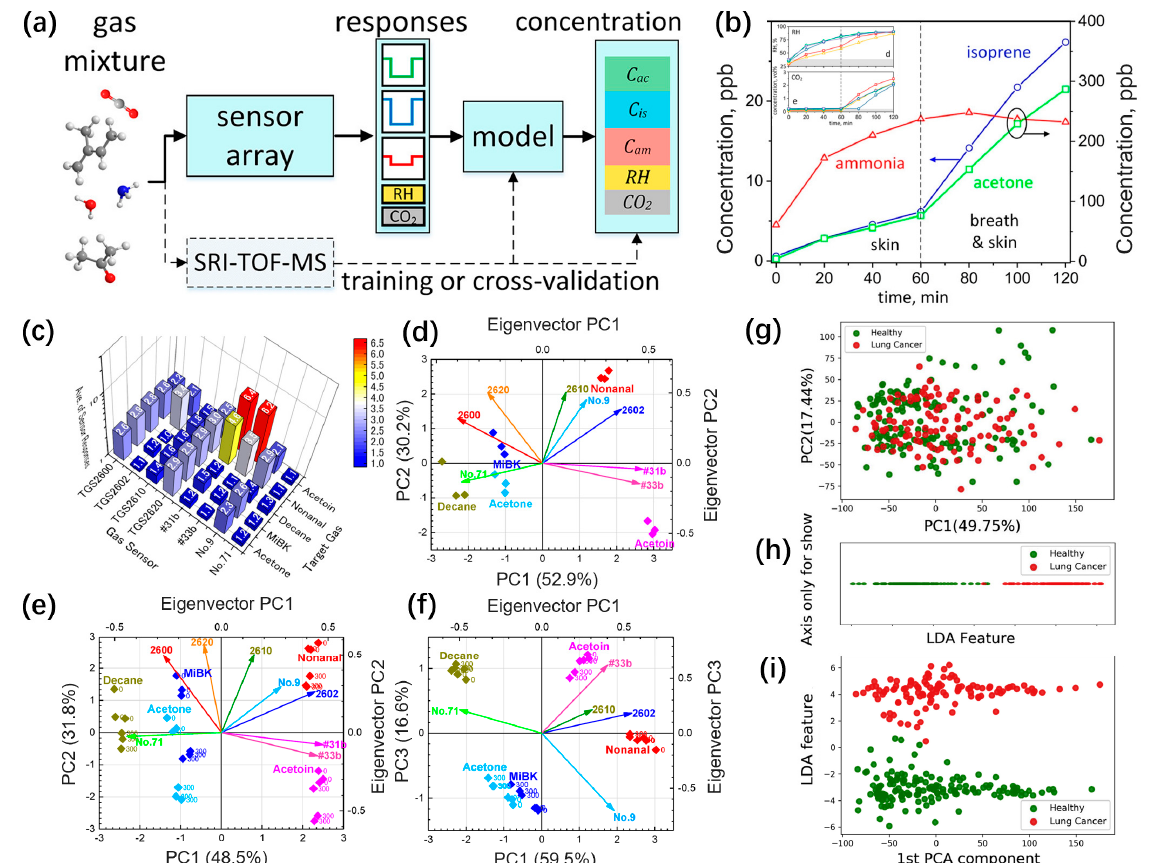
Figure 9. Sensor array and pattern recognition. ( a ) Schematic diagram of the sensor array. Each sensor individually analyzes mixed gases, and a statistical model converts their signals. Utilize SRI-TOF-MS for training or cross-validation. ( b ) Average sensor array measurements of five volunteers’ ammonia, isoprene, and acetone concentrations as a function of entrapment time (the inside picture, RH, and CO 2 gas-sensing results). ( c ) Average sensor responses of eight sensors to 1 ppm of target gases in pure humid air. PCA scores and eigenvectors from ( d ) eight sensors in pure humid air, ( e ) eight sensors and ( f ) five sensors in polluted humid air. The 2D mapping results of all “breath prints” in features space, extracted by ( g ) PCA, ( h ) LDA, and ( i ) LDA with PCA. Panels ( a , b ): reproduced with permission from Ref. [193], © 2018 American Chemical Society. Panels ( c – f ) from Ref. [198]. Panels ( g – i ): reproduced with permission from Ref. [199], © 2020 Published by Elsevier